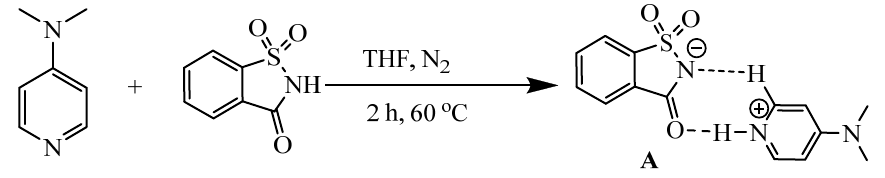
Scheme 1. Synthesis of the DMAP · HSac adduct ( A ).